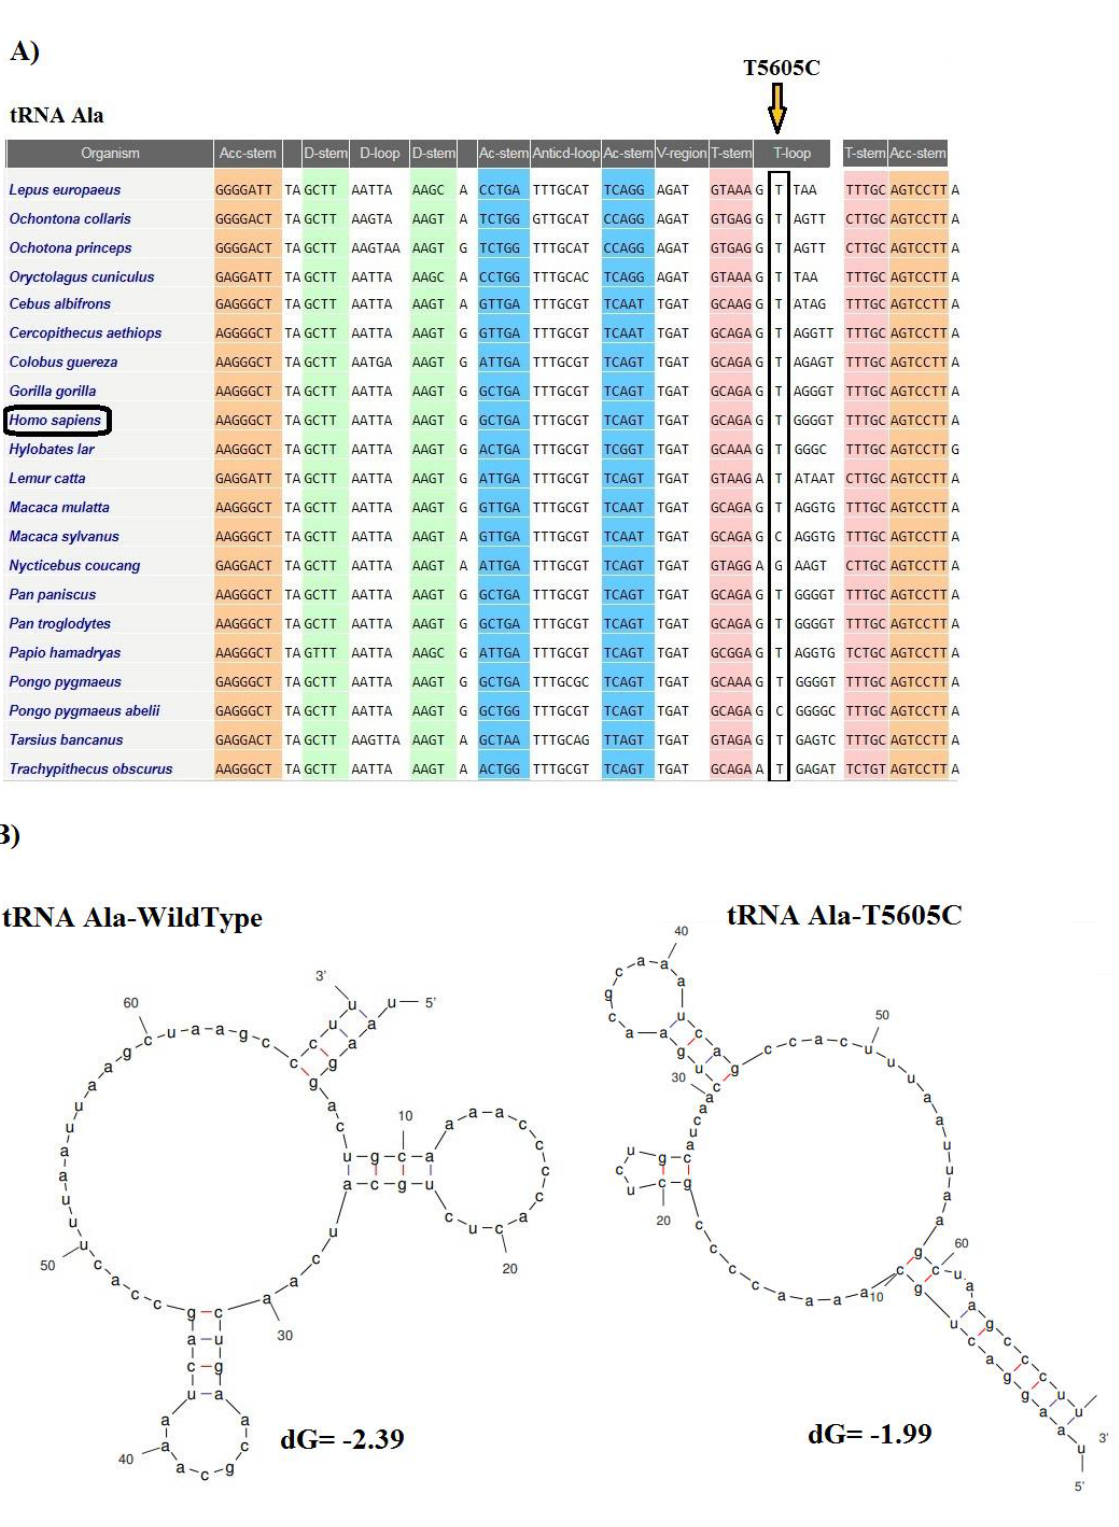
Figure 2: Sequence alignment of tRNA Ala reveals a high-degree of conservation across species. ( A ) The T at the position 5605 nucleotide is highly conserved among species. ( B ) Prediction of the structural and folding changes due to a T5605C mutation in tRNA Ala using the Mfold program. The free energy change between the mutant and wild-type states was